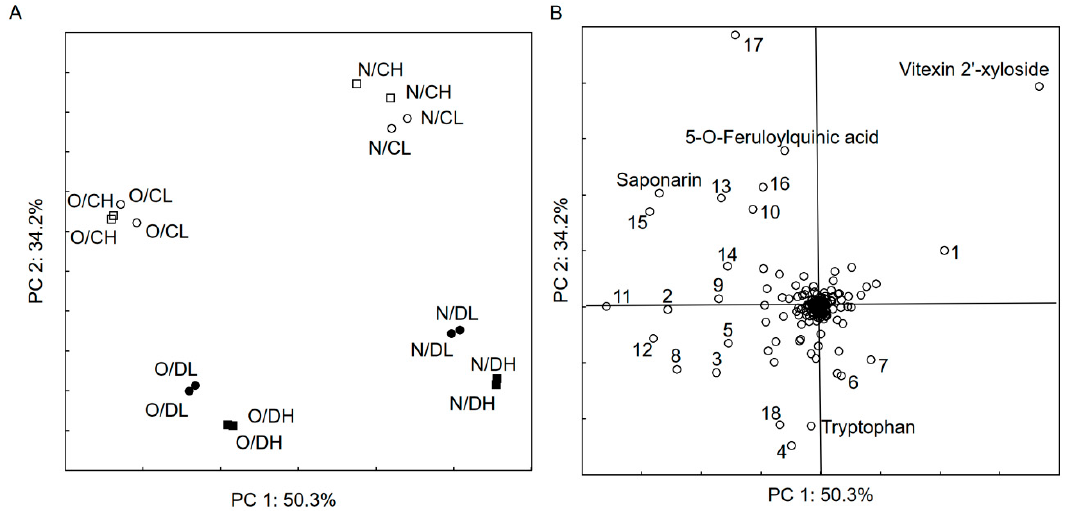
Figure 1. PCA, chemical profile of green barley samples determined by LC-MS. ( A )—score plot (O— KWS Olof , N— Nokia , C—control, D—drought, L—PAR = 400, H—PAR = 800), ( B )—loading plot (compounds—monoisotopic neutral mass_retention time: 1—522.24 Da_9.3 min, 2—372.11 Da_11.1